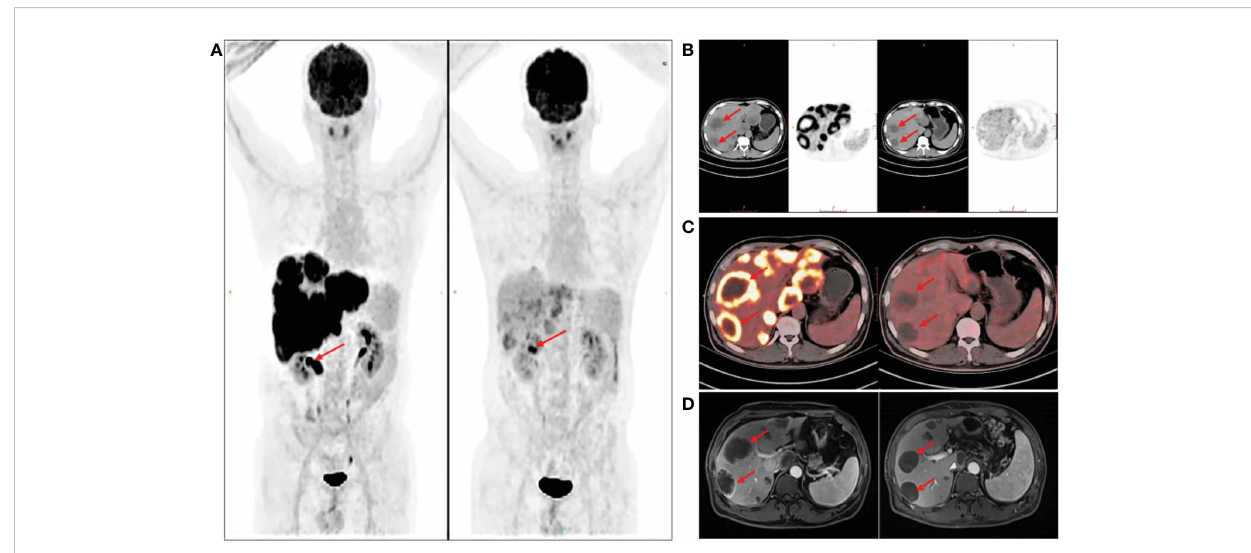
FIGURE 2 Drug-eluting beads transarterial chemoembolization (DEB-TACE), fl uorodeoxyglucose-positron emission tomography/computed tomography (FDG PET/CT) assessment. Six weeks after the second DEB-TACE, FDG PET/CT (A) showed that the SUVmax of liver fl exure and transverse colon lesions was decreased from 13.2 to 7.2. The SUVmax of some right lobe lesions was decreased from 14.0 to 5.3 (B, C) red arrow). Re-examination of contrast-enhanced abdominal MRI showed that the intrahepatic tumor volume was not signi fi cantly reduced, and the sum of target lesion diameters was less than 30% compared with the baseline level (D) .